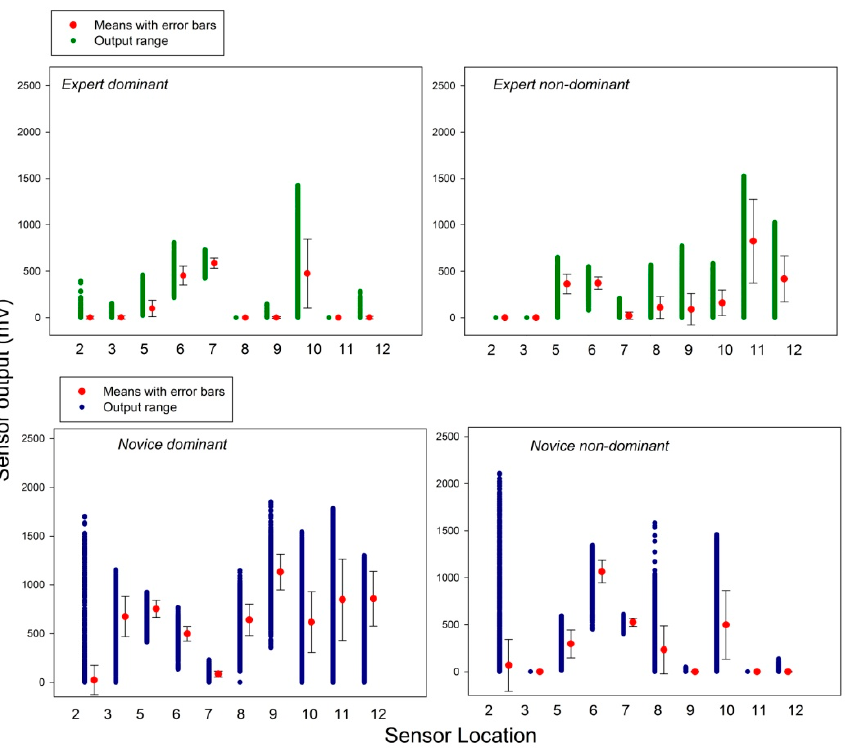
Figure 7. Sensor output range, with means across ten sessions and their standard errors for the expert and the novice performing with the dominant and the non-dominant hand.